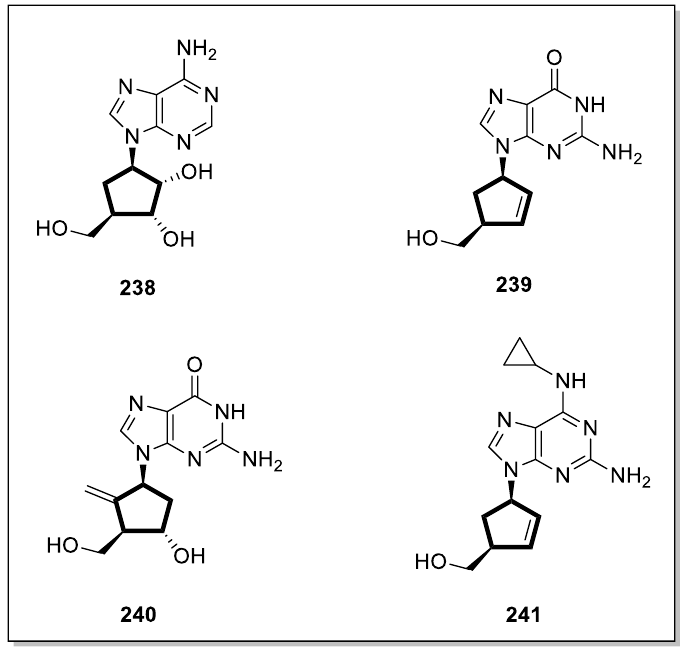
Figure 6. Structures of carbocyclic nucleosides 238 – 241